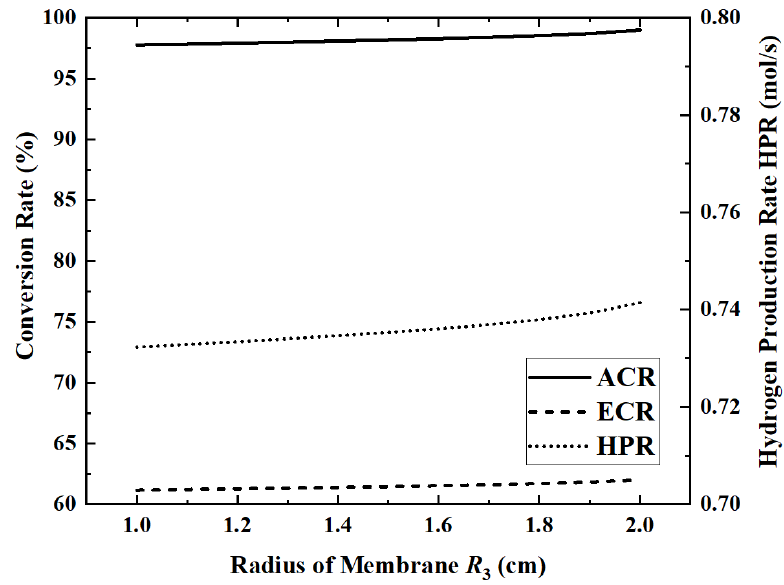
Figure 10. Effect of membrane radius on ACR, ECR and HPR.